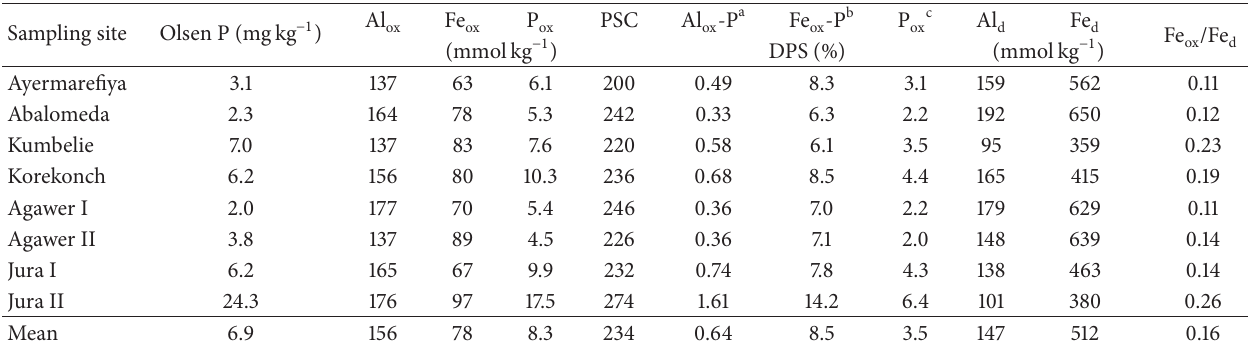
Table 7: Olsen P, oxalate extractable Al, Fe, and P, and citrate dithionite bicarbonate extractable Al and